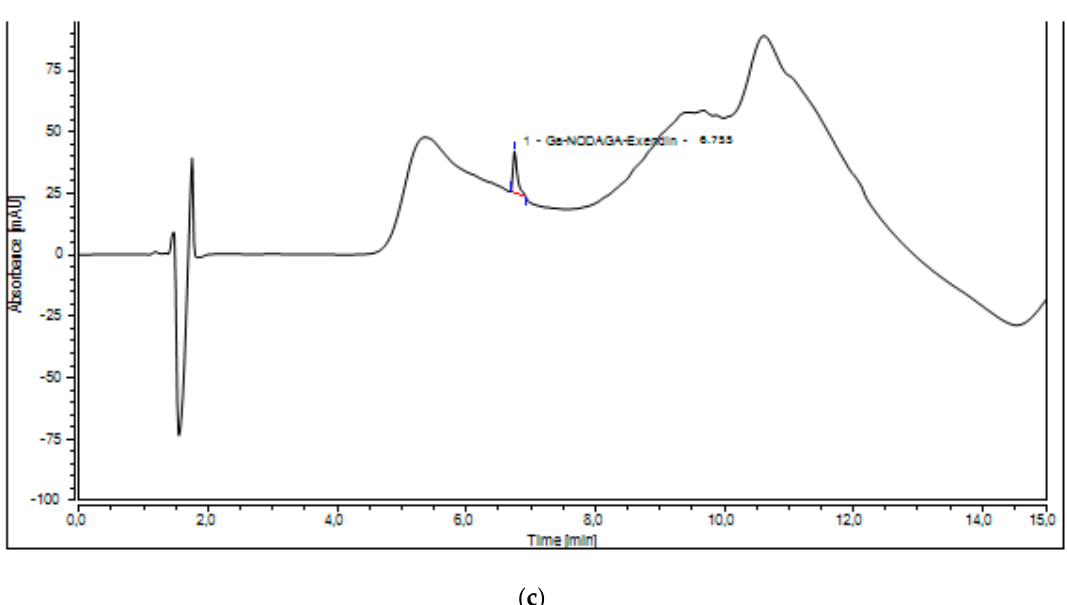
Figure 1. UV-Radio-HPLC traces of blank sample ( a ), NODAGA-exendin-4 ( b ), and Ga-NODAGA-exendin-4 ( c ). Pure and analytical grade eluents: 0.1% trifluoroacetic acid (TFA) in water (A)/0.1% TFA in acetonitrile (Bb), flow rate 0.6 mL min − 1 , column temperature 30 °C, wavelength of detection: 220 nm. The gradient elution profile: 0–7 min—5–100% B and 7–15 min—100–5% B. The calibration curve for the determination of NODAGA-exendin-4 and Ga-NODAGA-exendin-4 was linear over the range 5–0.75 µg/mL. The linearity of this method was statistically confirmed for each calibration curve (Figure 2).